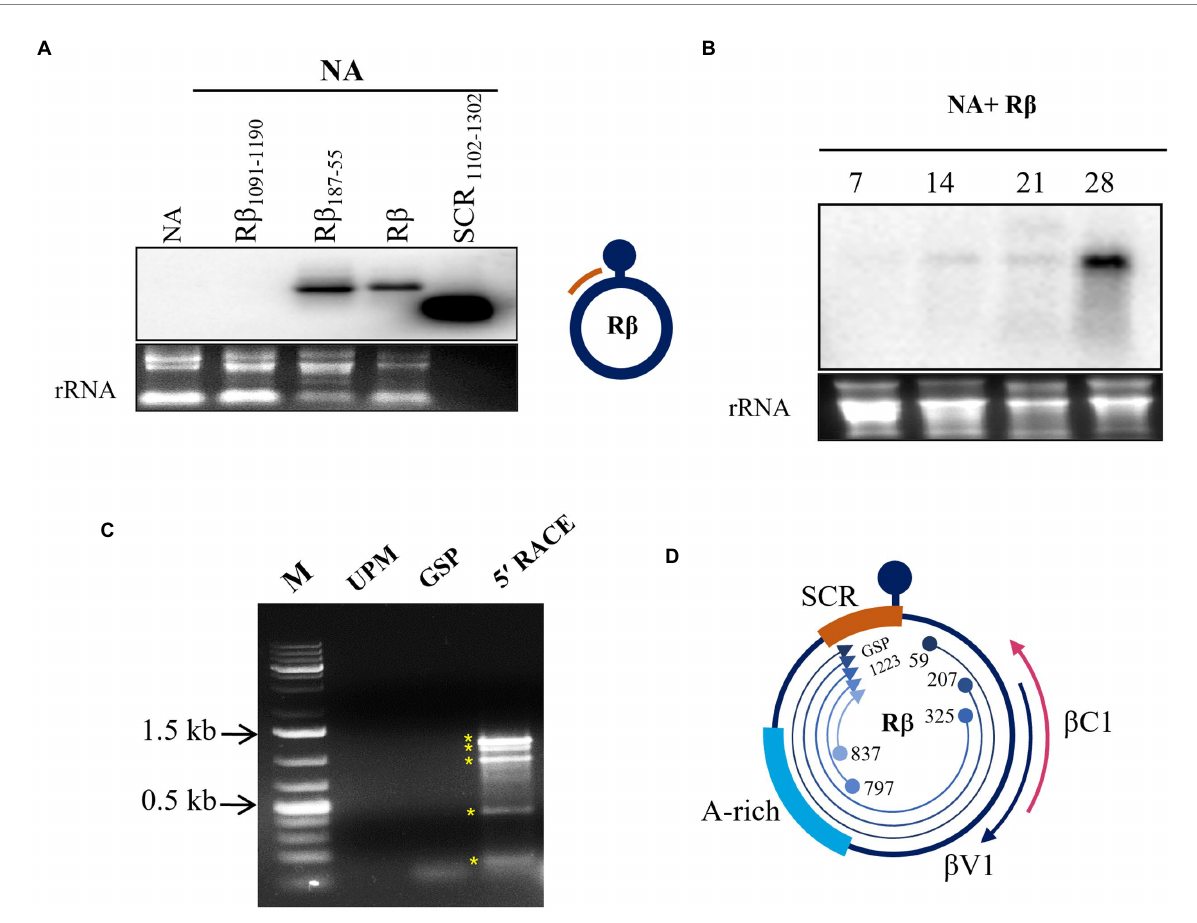
FIGURE 1 Transcript detection of R β specific transcripts from NA+ R β infected N. benthamiana plants. Total RNA extracted from NA alone and NA with R β 1091- 1190, R β 187-55 and R β inoculated plants at 19 dpi used for hybridization with SCR specific radiolabelled probe. (A) Hybridization signals are detected in R β 187-55 and R β . The DNA used for probing served as positive control and the location of probe from R β indicated in orange color. (B) Temporal expression of SCR specific transcripts was detected during the disease progression at 7, 14, 21, and 28 dpi. Ethidium bromide-stained ribosomal RNA (rRNA) used as a loading control. (C) 5 ′ RACE nested PCR of virion sense SCR transcript mapping. M indicates DNA marker, UPM and GSP stands for universal primer mix and gene specific primer, respectively, which served as a negative control for 5 ′ RACE and nested PCR amplicons, indicated with asterisks (*). (D) Schematic presentation of R β and overview of SCR originated 5 ′ RACE transcript mapping. Location, orientation of TSS and GSP binding site are